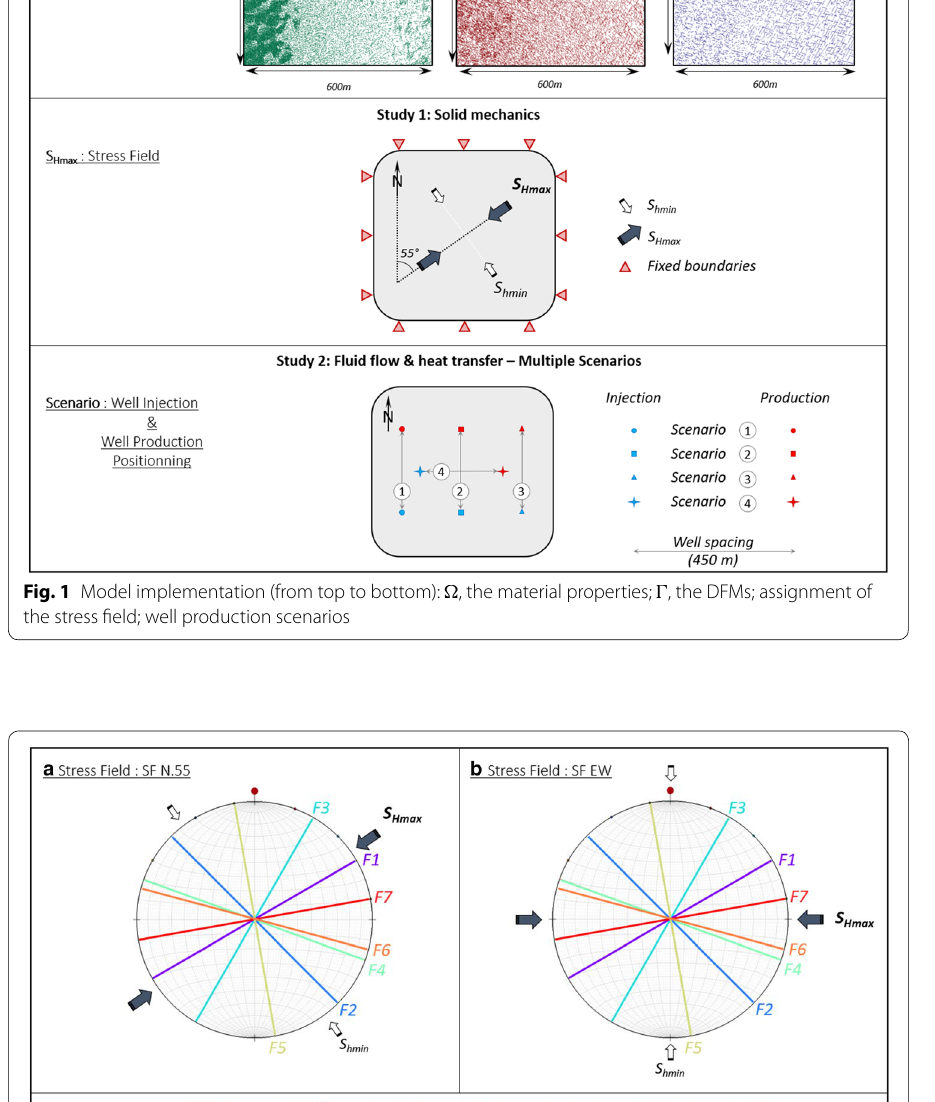
Fig. 2 Stress field orientation and fracture sets: a stress field where S Hmax is N55°; b stress field where S Hmax is